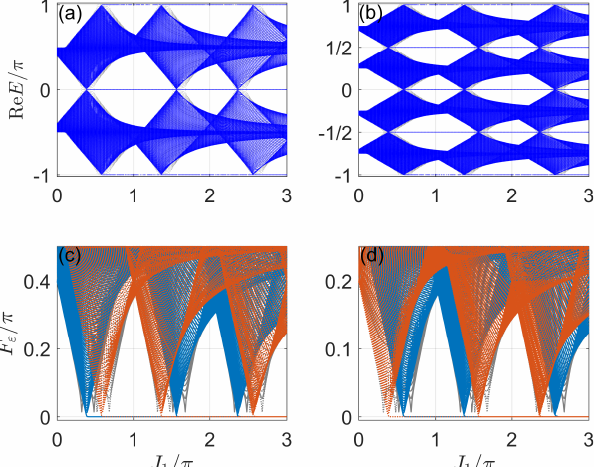
[ Eq. (25) ] Figure 2: Floquet spectrum E and gap function F (cid:34) of U 1 / 2 and U versus J under OBC and PBC. Other system parameters are set as 1 ( J , µ , λ ) = ( 0.5 π ,0.4 π ,0.25 ) and the length of lattice is L = 400. (a) and (b) show 2 the values of the real part of E for the parent and square-root models described by U and U under the OBC (PBC) in blue (grey) dots, respectively. The blue solid and 1 / 2 red dotted lines denote the gap functions F and F π of U in (c), and the gap functions 0 F ( = F π ) and F π/ of U in (d) under the OBC. Grey solid and dotted lines denote 0 2 1 / 2 the same gap functions under